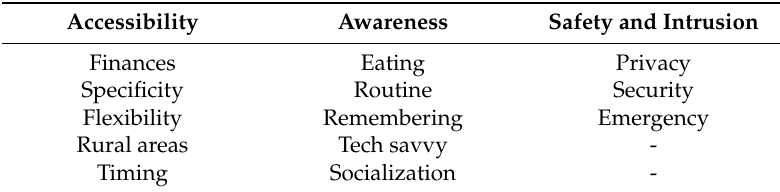
Table 3. Qualitative categories and themes.